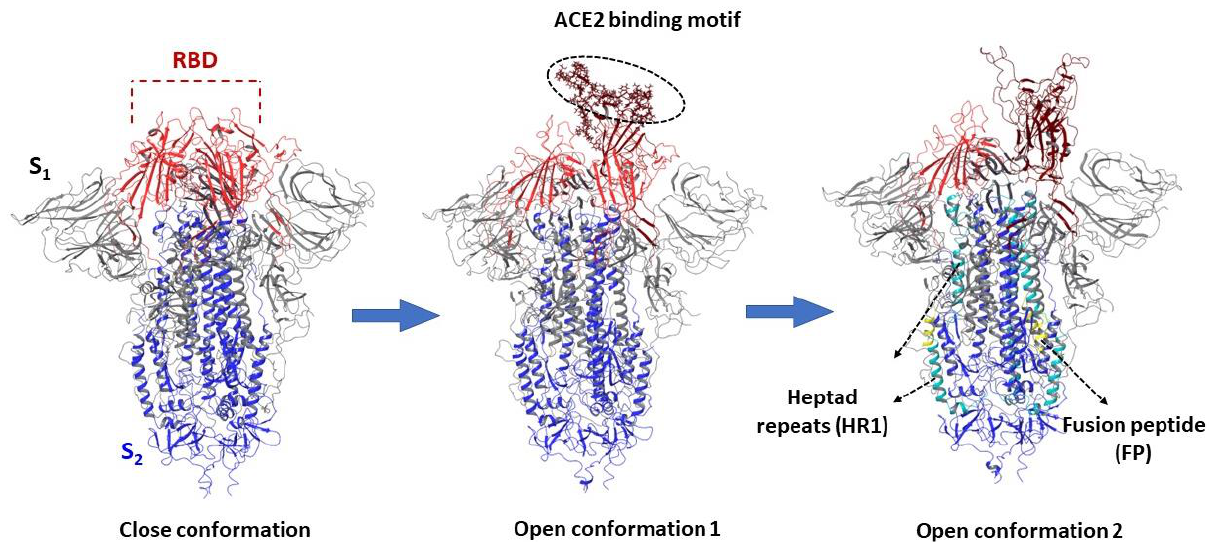
Figure 10. Sequential opening of RBD in the “bulb” head of the S-protein of SARS-CoV-2. The secondary structures of subunits S 1 and S 2 are shown in gray and blue, respectively, and the RBD in red. In the open conformation, two heptad repeats (HR1, a. a. 910–985) are highlighted in light blue. The fusion peptide (FP, a. a. 816–834) is shown as a yellow secondary